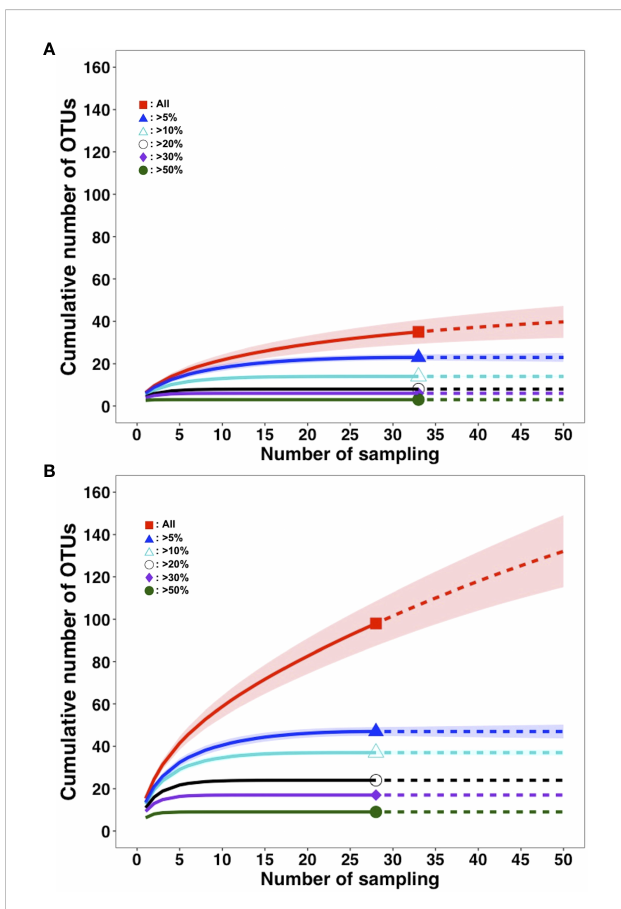
FIGURE 6 Accumulation curves of fi sh OTUs detected from eDNA at Akazawa and Yaizu by sampling effort. Accumulation curves based on occurrence rate among replicates at (A) Akazawa and (B) Yaizu. Lines and dotted lines indicate sample-size-based rarefaction and extrapolated sampling plots, respectively. Observed numbers of OTUs were denoted by symbols. Shadings indicate 95% con fi dential interval. Red squares: all OTUs applied; blue triangles: OTUs with more than 5% occurrence; light blue triangles: OTUs with more than 10% occurrence; white circles: OTUs with more than 20% occurrence; purple diamonds: OTUs with more than 30% occurrence; green circles: OTUs with more than 50%